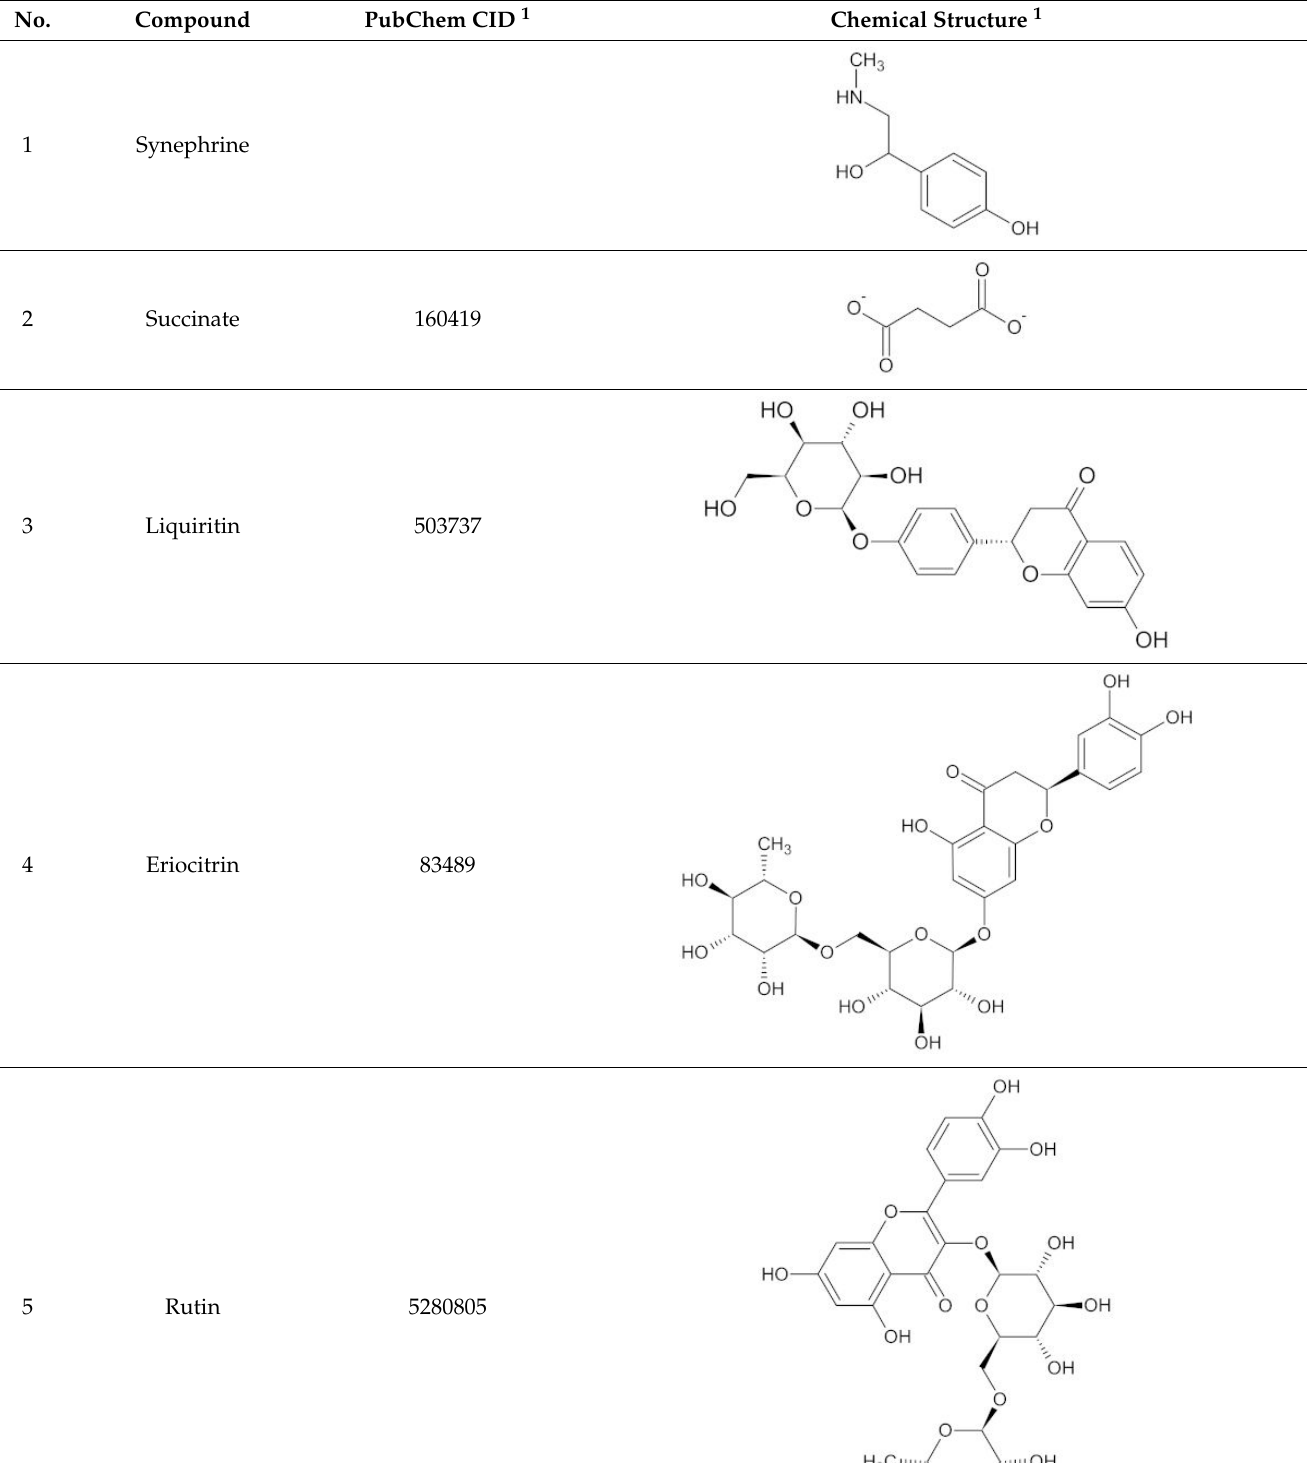
Table 3. A list of the bioactive compounds contained in WDT, as defined by Zhang et al.